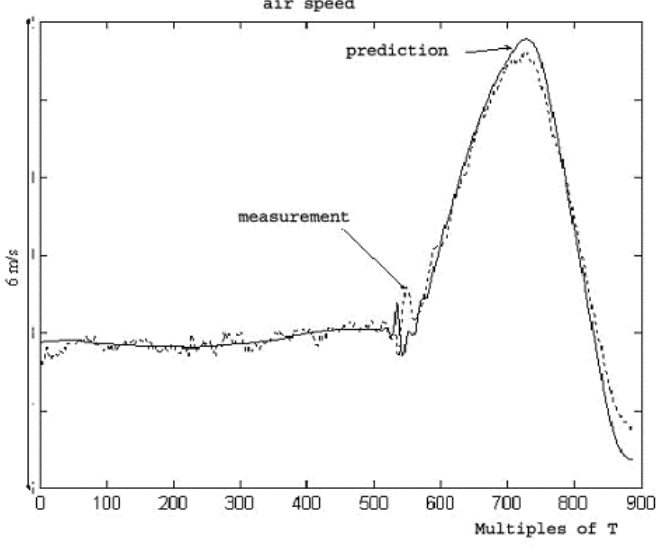
Fig. 3. True air speed: measurements and prediction.